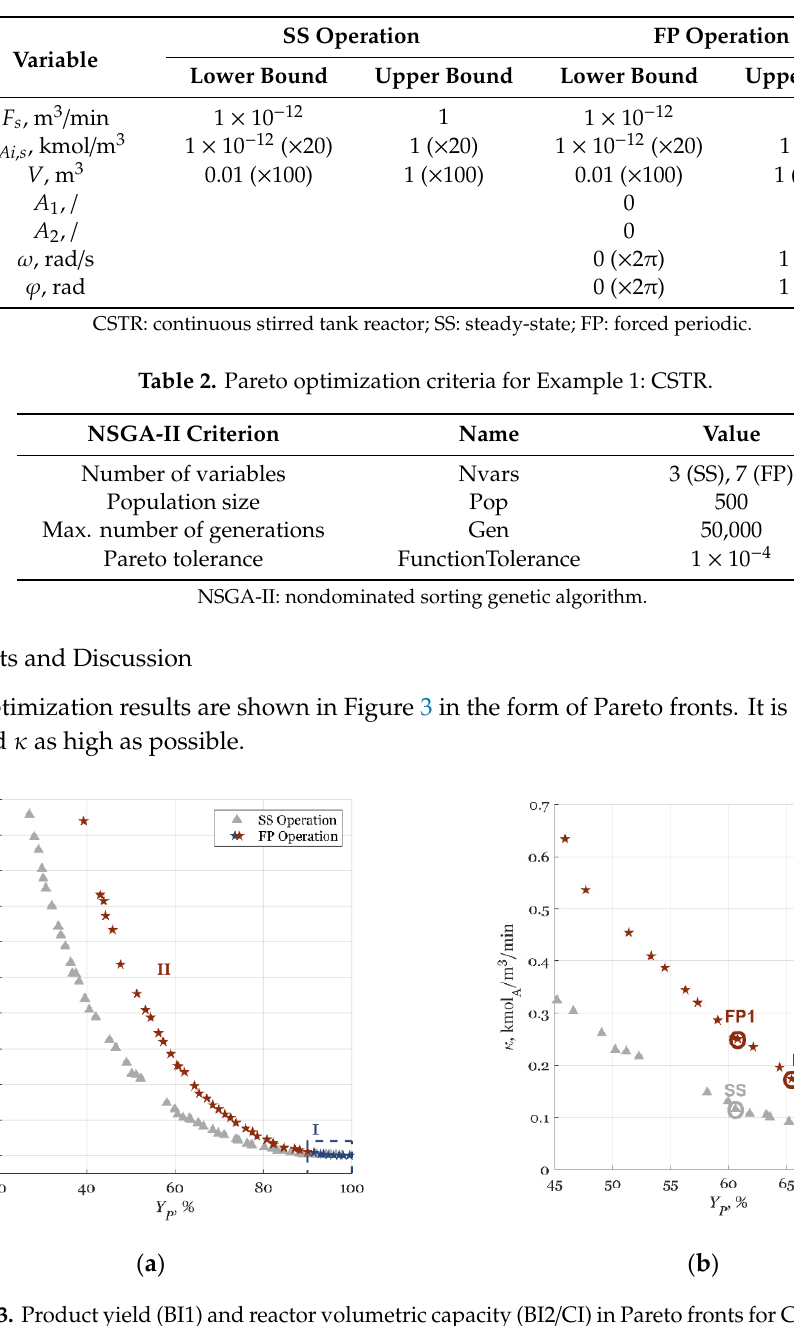
bounds with scaling values (in brackets).